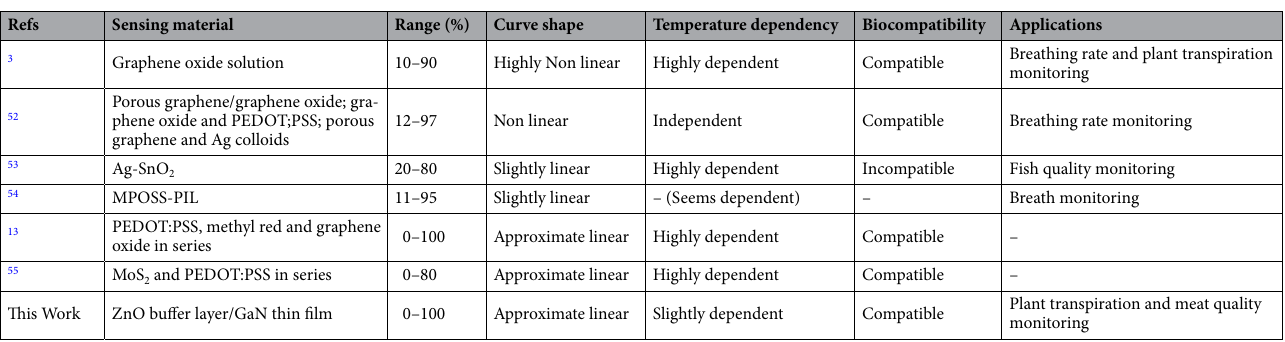
Table 2. Comparison table of biocompatible humidity